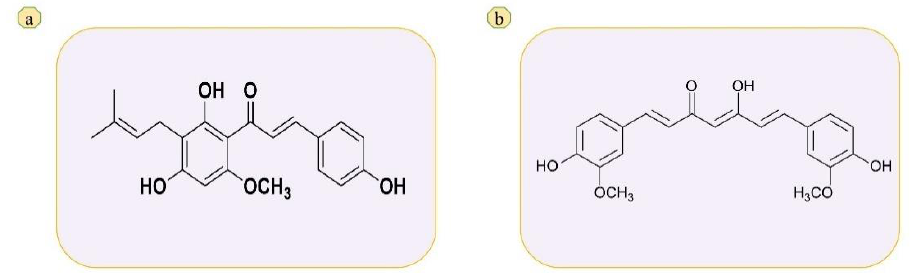
Figure 1. Chemical structure of ( a ) XH and ( b ) curcumin.